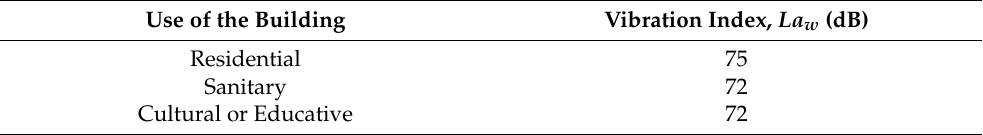
Table 2. Noise quality objectives for vibrations applicable to the habitable interior space of buildings intended for residential, hospital, educational or cultural uses. Reference: Table C of Annex II. Noise quality objectives